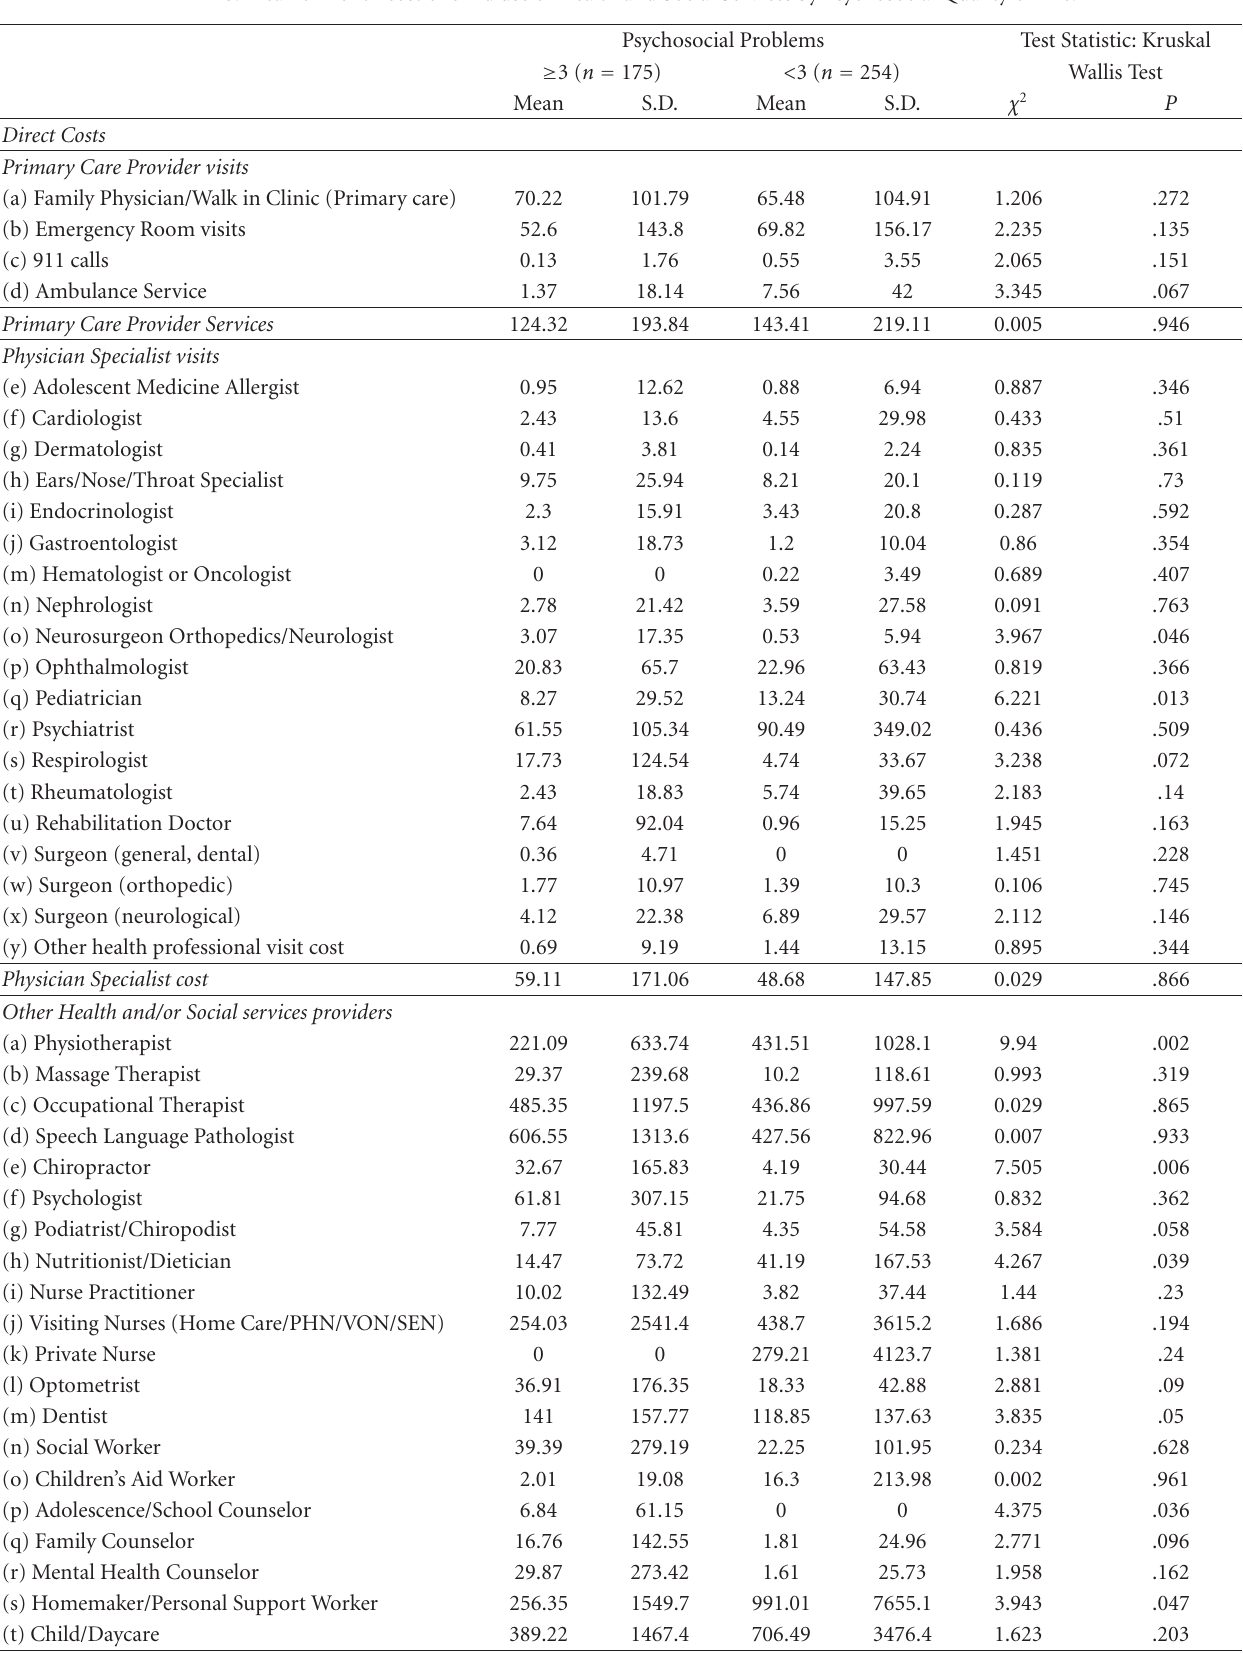
Table 8: Mean 6-month cost of child use of Health and Social Services by Psychosocial Quality of